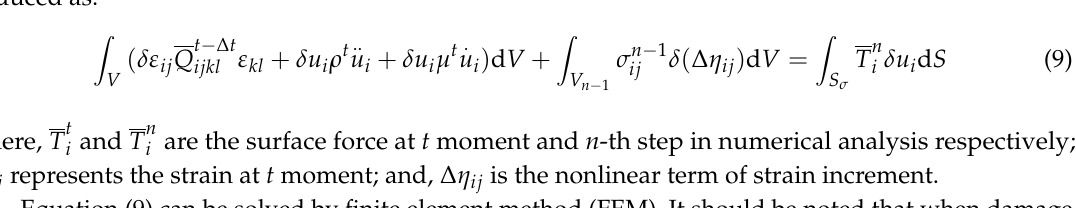
Table 1. Expression of six damage modes for low-velocity impact.